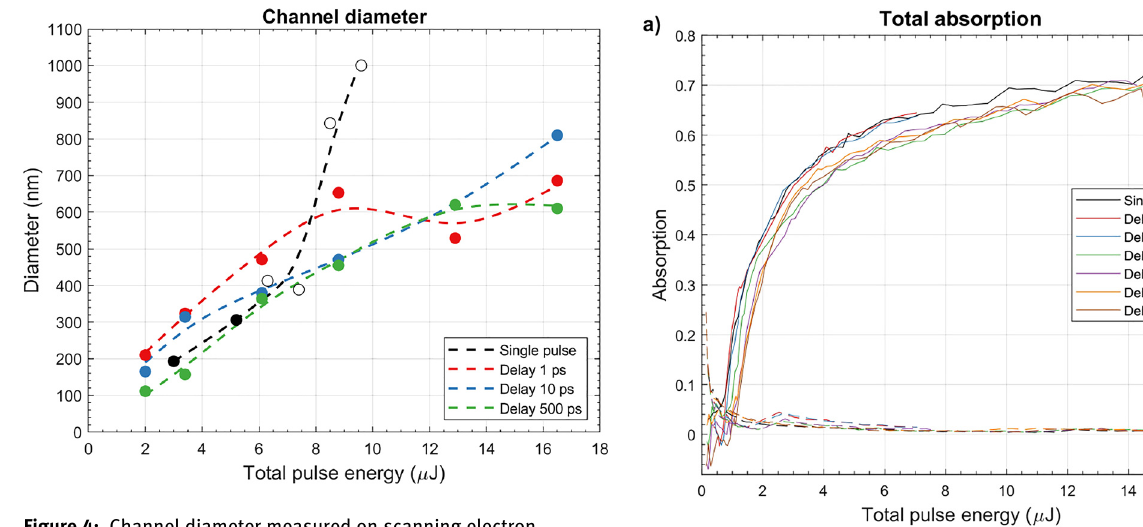
Figure 4: Channel diameter measured on scanning electron microscopy (SEM) images for modifications made using single and double pulses with inter-pulse delays of 1, 10 and 500 ps, at a depth of 5 μ m below the surface of the output facet. Filled dots correspond to the formation of a void channel, while circles correspond to refractive index modi fi cation. Dashed lines correspond to B-spline interpolation. The horizontal axis corresponds to the total energy in all